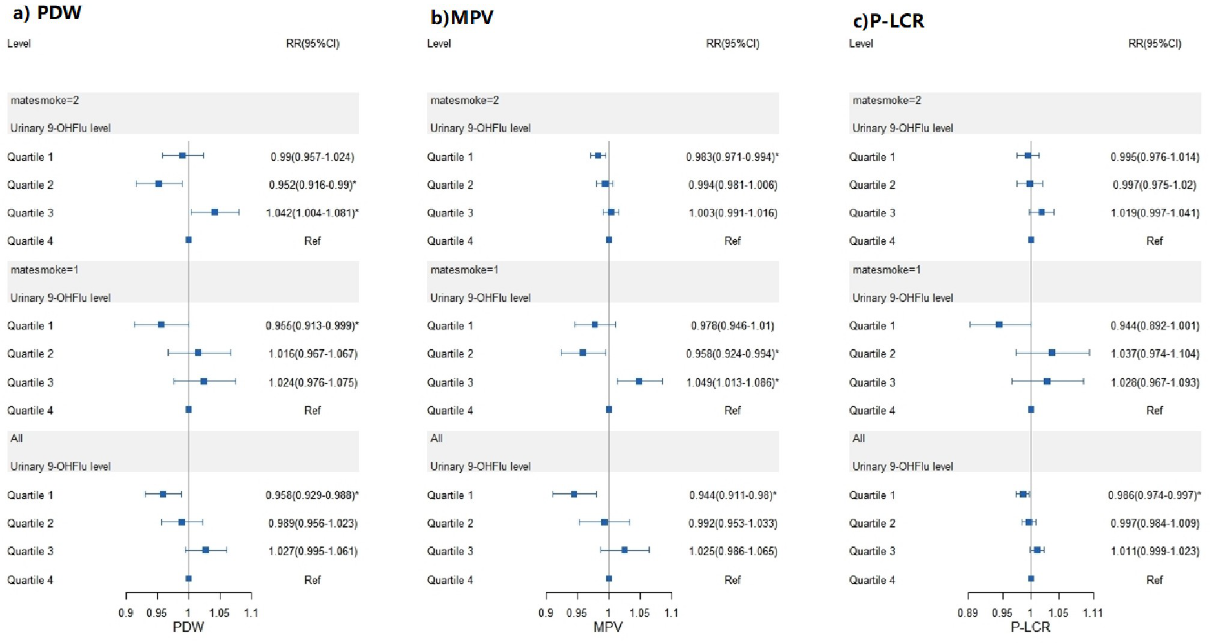
Fig 3. The effect of the second-hand smoke to the correlations observed between 9-OHFlu levels and platelet indices. Whether the correlations were true or confounded by exposure to second-hand smoke. “Matesmoke = 1” stands for without the effect of the second-hand smoke, while the “Matesmoke = 2” stands for the subgroup with the effect of the second-hand